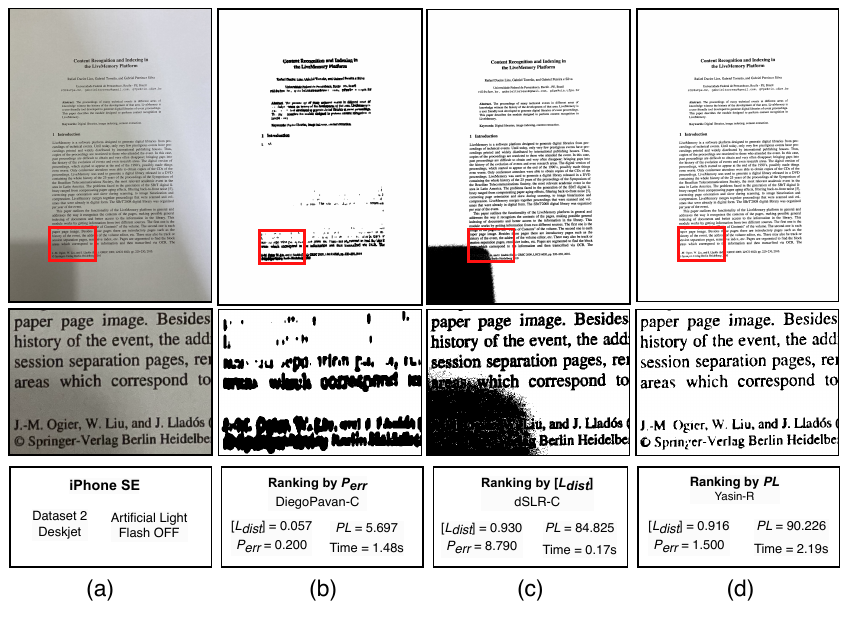
Figure 2. Comparison between different measures: PL , [ L dist ] , P err . For each case, the full image is shown on the top and an example region bellow, where the red boxes indicates the crop position for the example region. ( a ) Original image; ( b ) Ranking by P err only, DiegoPavan-C binarized image; ( c ) Ranking by [ L dist ] only, dSLR-C binarized image; ( d ) Ranking by PL measure, Yasin-R binarized